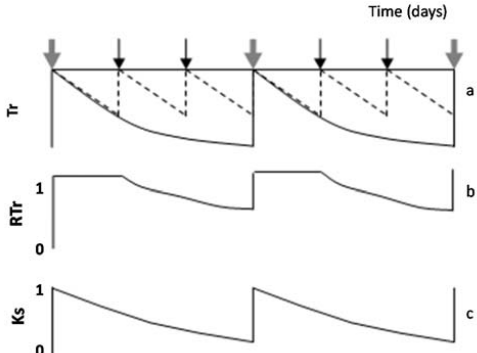
Figure 4. Diagram of the evolution along several days of ( a ) Tr in the plot considered well irrigated by the farmer (dashed line) and a stressed plot (black line); ( b ) RTr and ( c ) Ks in a stressed plot, for two consecutive stress cycles, during which irrigation takes place in the well irrigated six times and in a stressed plot only two times. Black arrows denote irrigation only in the well-irrigated plot, and grey arrows denote irrigation in both plots (proportions not respected). Adapted from Ferreira et al. [19].